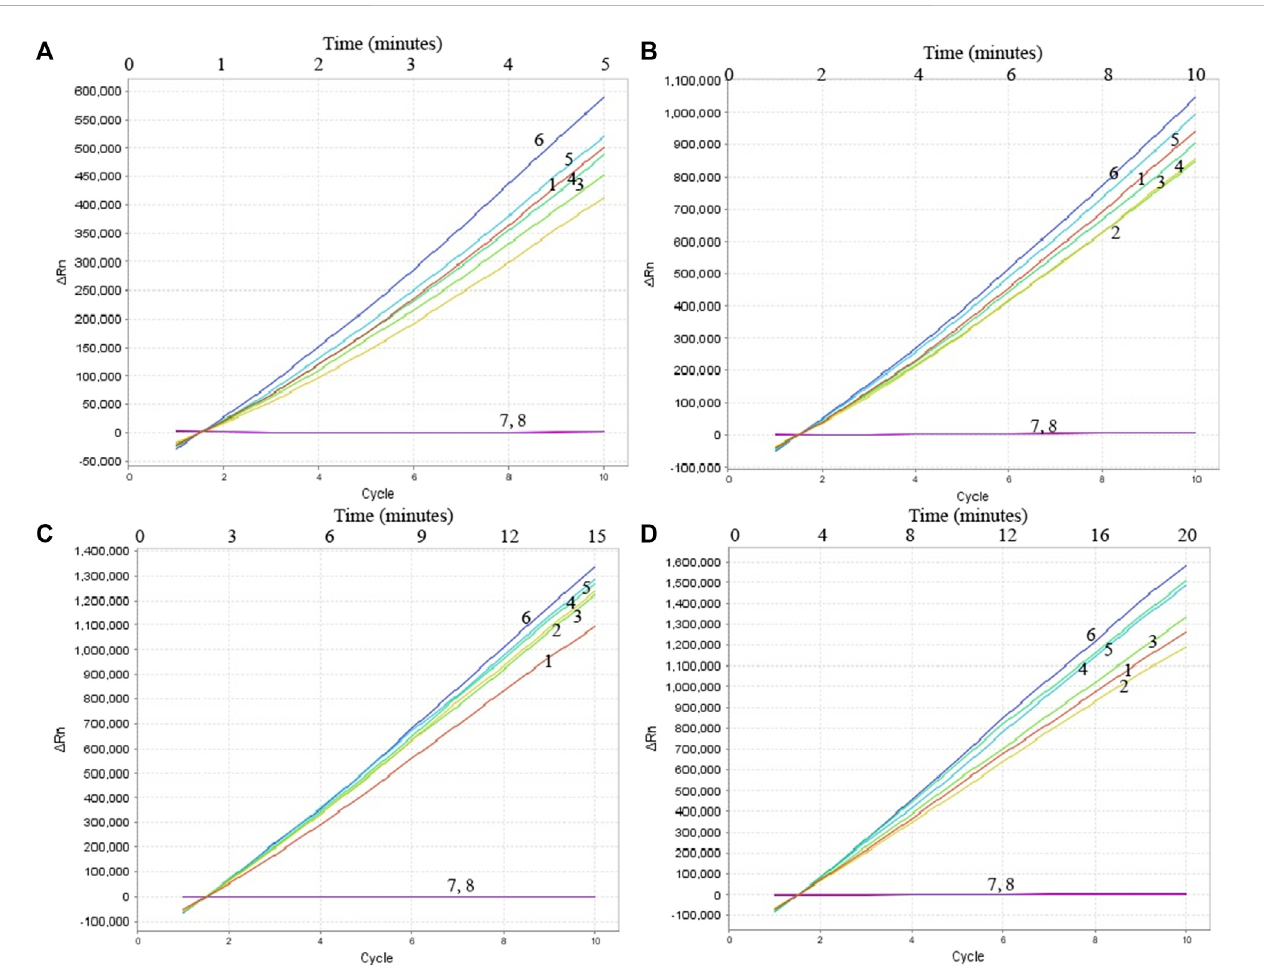
Optimization of reaction time of CRISPR-Cas12a-based biosensing system. Real-time fl uorescence detection was used for reporting the CRISPR- Cas12a-gRNA cleavage results at 5 min (A) , 10 min (B) , 15 min (C) , and 20 min (D) . Stable fl uorescence signal can be detected within 5 min. Curves 1 – 7,